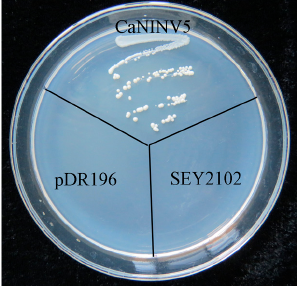
Figure 9. Complementation of the invertase-deficient strain SEY2102 with CaNINV5. S. cerevisiae strains were grown on SD media, which lacked uracil and had Suc as the sole carbon source, at 28 °C for 3 days. CaNINV5: the pDR196- CaNINV5 vector was transformed into SEY2102; PRD196: the empty pDR196 vector was transformed into SEY2102; SEY2102: the mutant yeast cells without any vector transformation.